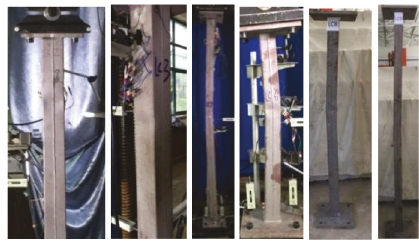
Figure 6: Snapshots of a member failure. Table 4: Buckling test results of BS700 HSS groove butt welding box-section